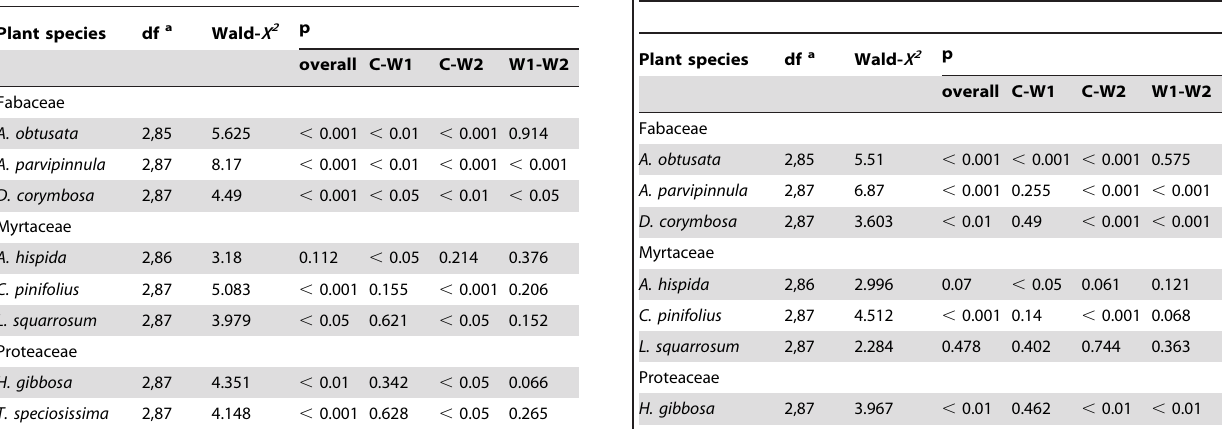
Table 3. Summary statistics for multivariate generalised linear model analyses (mGLM) of feeding guild species richness data, for only the herbivore Coleoptera and Hemiptera guild structure; pair wise comparisons between sites are